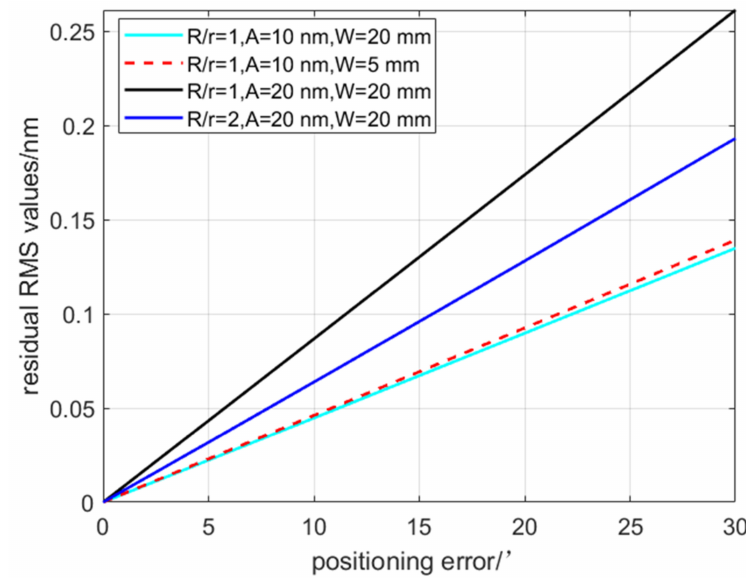
Figure 14. Residual error caused by angle